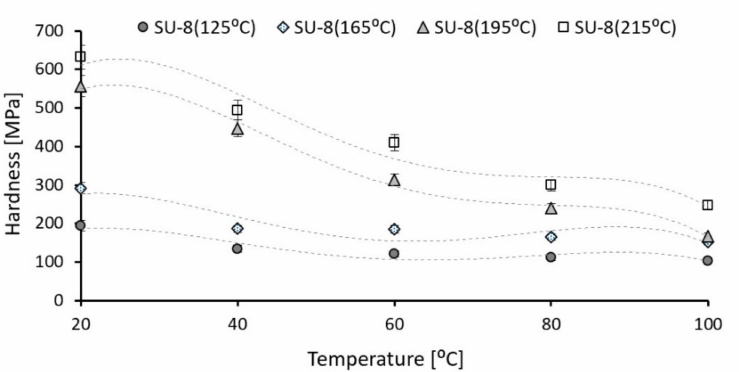
Figure 7. Testing temperature influence on hardness of SU-8 hard baked at different temperatures (error amount percentage less to